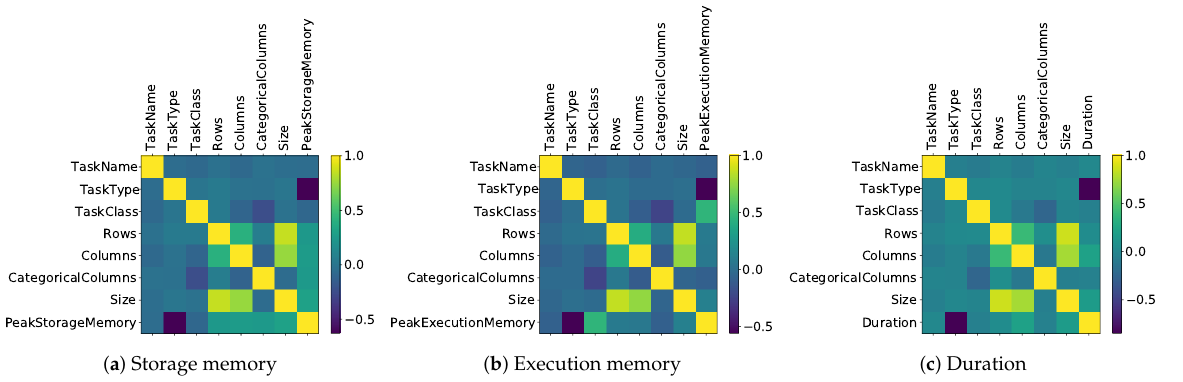
Figure 1. Correlation of target variables with the other features.